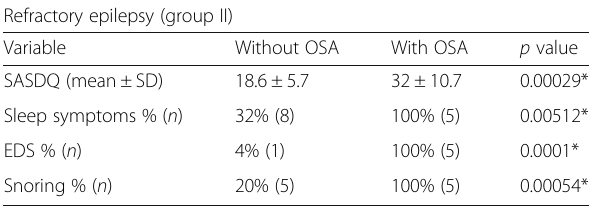
Table 7 Comparison between patients with and without OSA in group II regarding sleep-related clinical data Refractory epilepsy (group II)